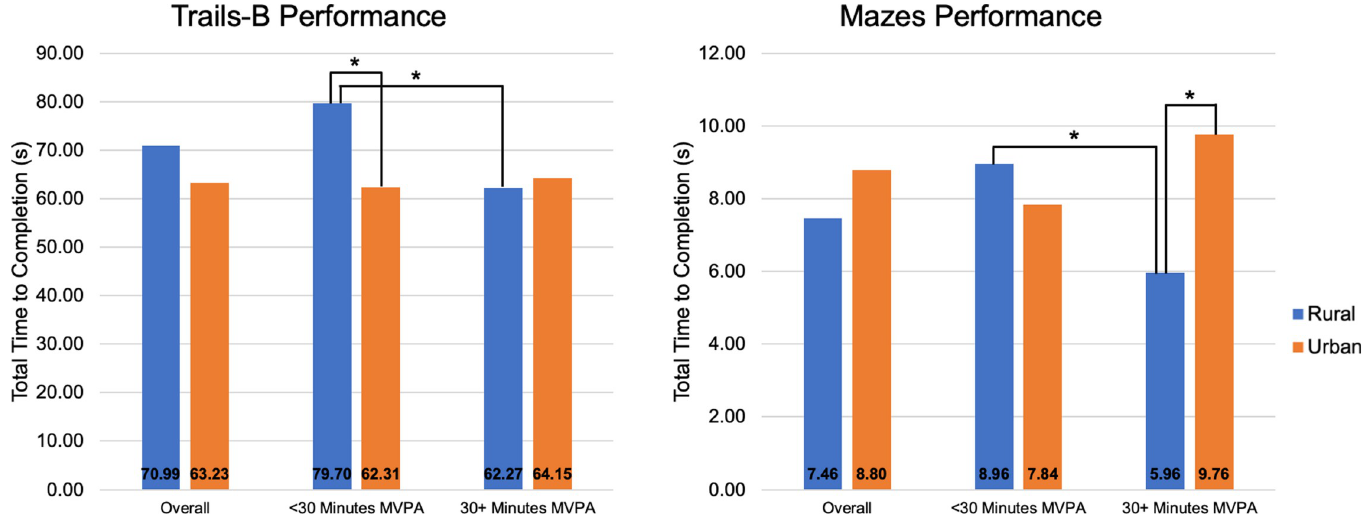
Fig 1. Trails-B and Mazes by rurality and MVPA status. * Significant difference, p < 0.05. Estimated Marginal Means adjusted for age, education, diagnosis stage, time since diagnosis, receipt of chemotherapy, months of hormonal therapy, history of depression.